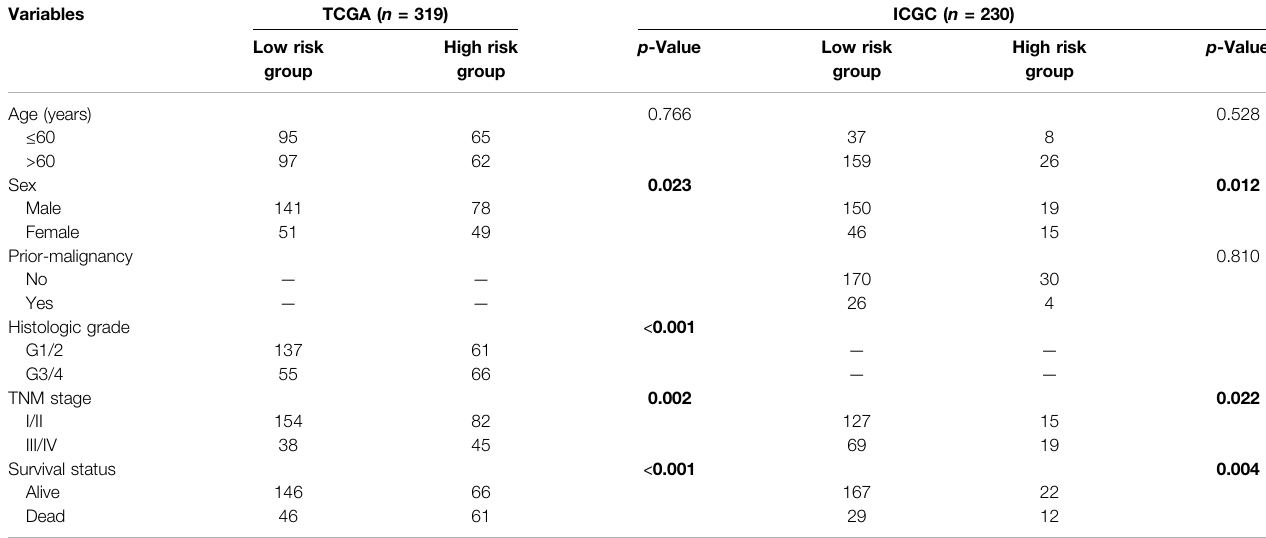
TABLE 3 | Association between m6A-correlated lncRNA signature and clinicopathologic characteristics in HCC cohort. Variables TCGA ( n = 319) ICGC ( n = 230) p -Value Low risk p -Value Low risk High risk High risk group group group group Age (years)